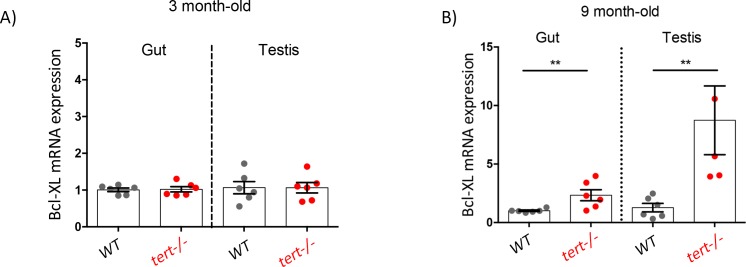
Bcl-XL is overexpressed in 9 month but not 3-month-old tert-/-.RT-qPCR analysis of Bcl-XL in gut and testis of 3- or 9-month-old tert-/- or WT siblings (N = 6 fish). While no differences are seen at 3 months (A), Bcl-XL is overexpressed in 9-month-old (B) tert-/- gut and testis compared to WT. Graphs are representing mean ± SEM mRNA fold increase after normalisation to rpl13a gene expression levels (** p-value<0.01, using t-test).Figure 1—figure supplement 2—source data 1.Real-time qPCR data of Bcl-XL, as plotted in Figure 1—figure supplement 2.